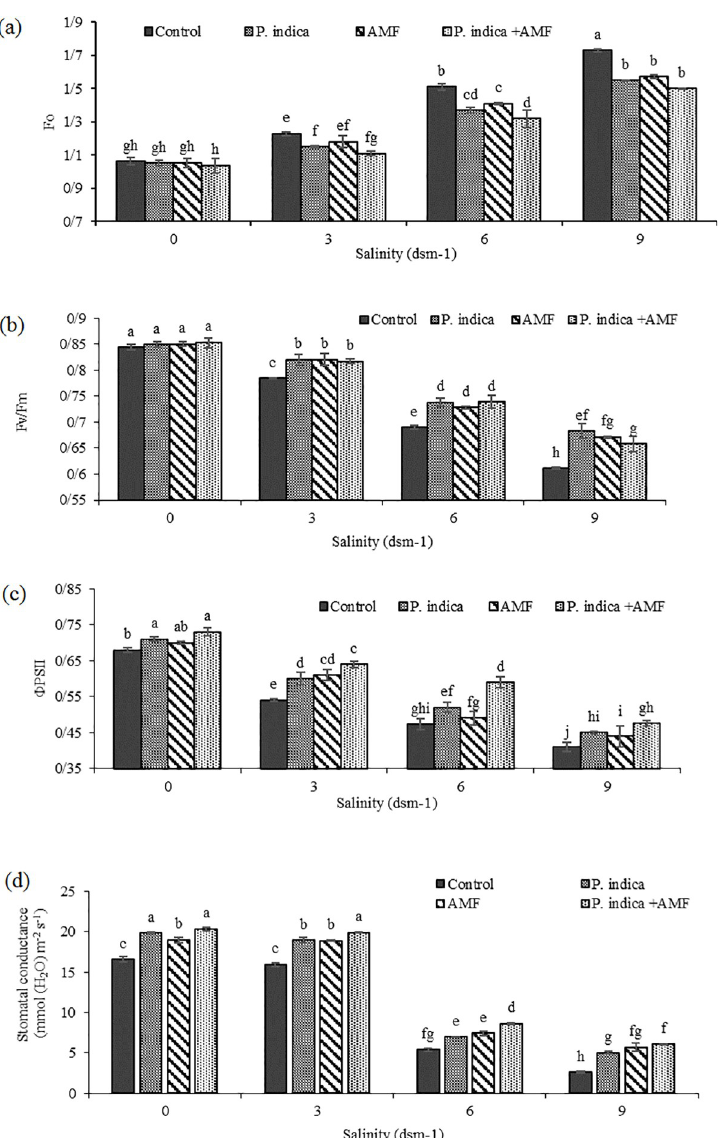
Fig 5. Effect of salinity on Fo (a), F PSII (b), Fv/Fm (c) and Stomatal conductance (d) in inoculated and non- inoculated peppermint with ( P . indica , AMF and